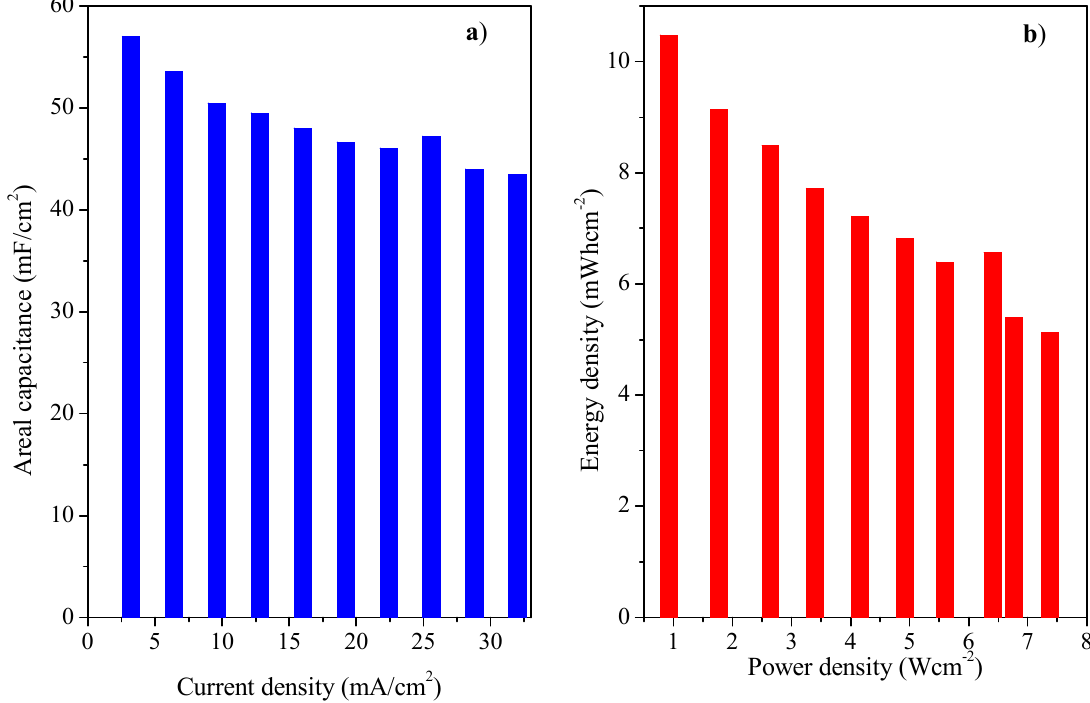
Figure 6. ( a ) Areal capacitance versus current density. ( b ) Ragone plot. Table 1. A performance comparison of specific capacitance values in this work with previous asymmetric SCs. S. No